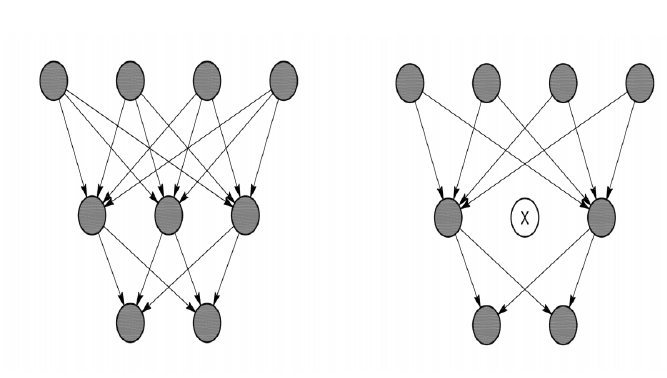
Figure 2. Basic concept of node/filter pruning in a deep convolutional neural